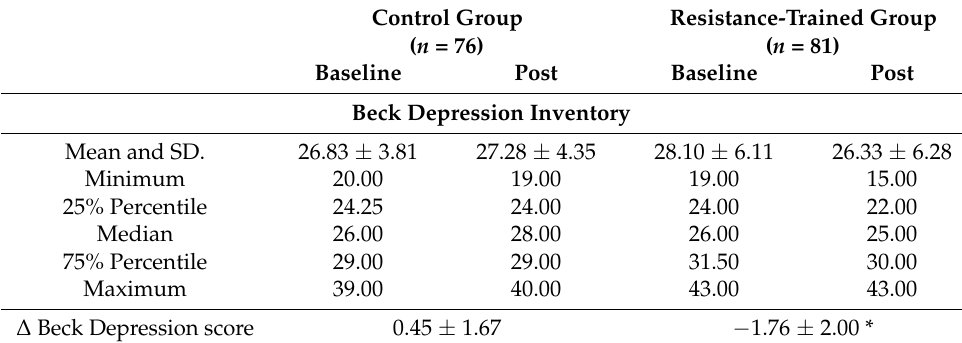
Table 5. Baseline and post-intervention Medical Outcomes Study—SF36 between control and resistance-trained group.